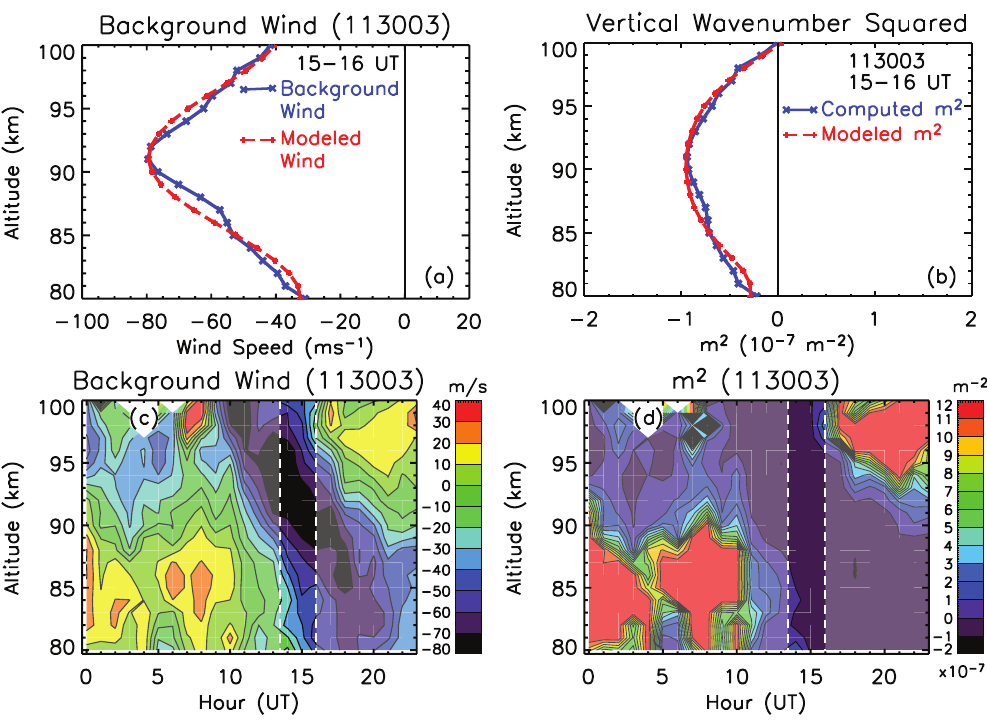
Fig. 3. Plots for 30 November 2003 evanescent wave event depicting the vertical profiles of (a) the measured (blue-solid) and modeled (red- dashed) background wind fields with respect to wave propagation, (b) the Taylor-Goldstein vertical wavenumber squared ( m 2 ) computed for measured (blue-solid) and modeled (red-dashed) background wind fields. Contour plots depict (c) the measured background wind field over the course of the wave event (13:00–16:00UT) and diurnal cycle, and (d) the calculated m 2 drived from background wind and wave parameters over the course of the wave event (13:00–16:00UT) and diurnal cycle.